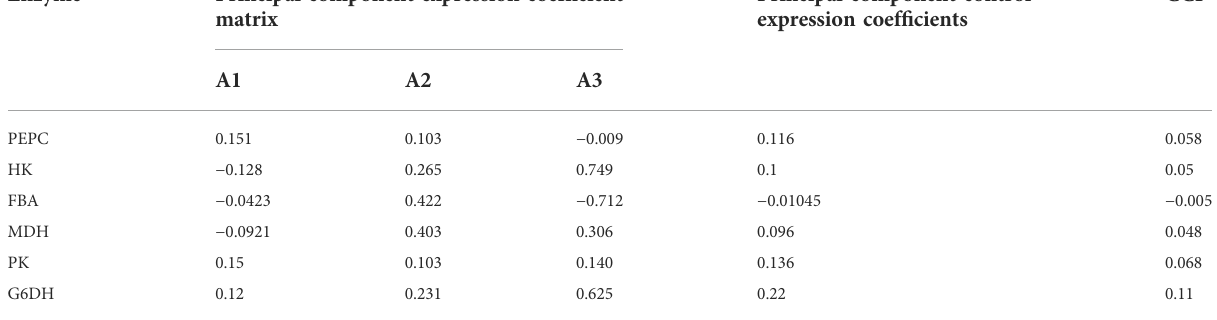
TABLE 6 Comprehensive express coef fi cient matrix and control coef fi cients based on principal component analysis.